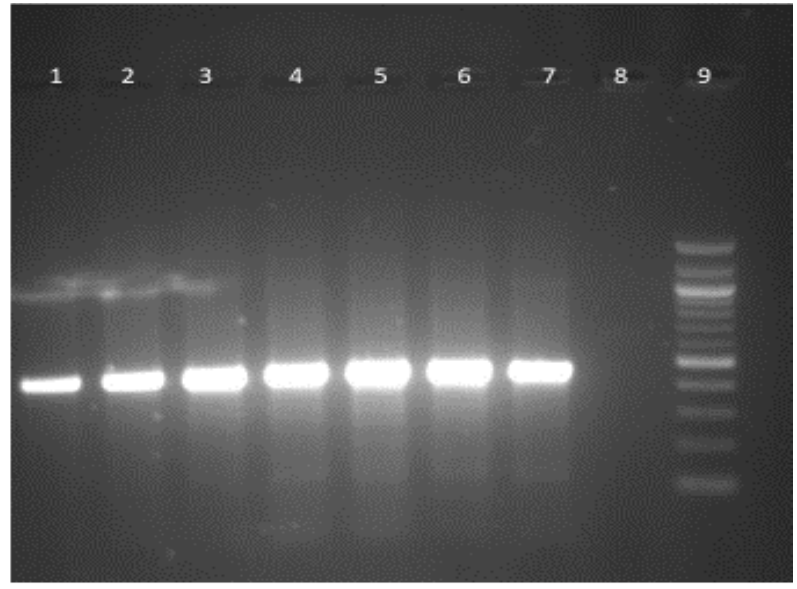
Figure S3 : Virulence gene ( ail ) of Yersinia enterocolitica (singleplex PCR amplification). Lane 9: 100 bp ladder; Lane 8: Negative control; Lane 1-6: Positive ail isolates (454bp); Lane 7: Positive